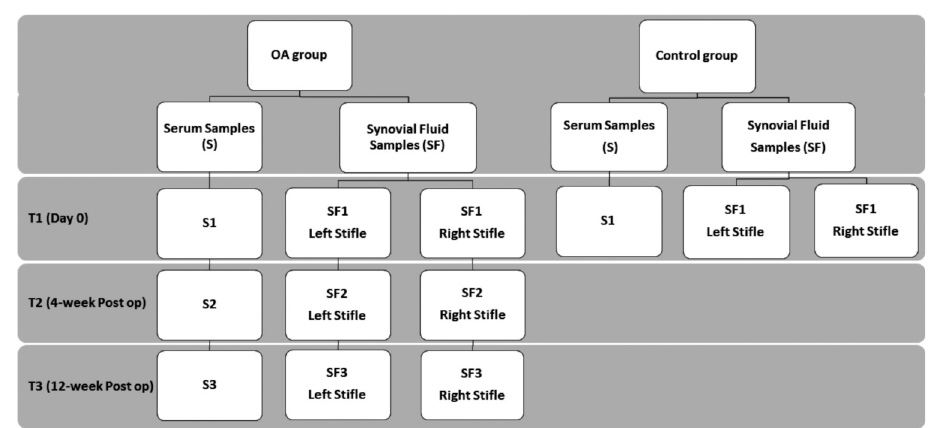
Fig 1. Flow diagram of serum (S) and synovial fluid (SF) sampling from control and osteoarthritis (OA) groups. Samples from the OA group were obtained at three time points and only once from the control group. Samples obtained from stifles in control dogs were labeled as controls while samples from right and left stifles of OA group were labeled as index stifle or contralateral stifle depending on whether the cranial cruciat ligament was intact or not. Only a subset of the dogs in the OA group were recruited for sampling at T2 (4-week post op) and T3 (12-week post op) time